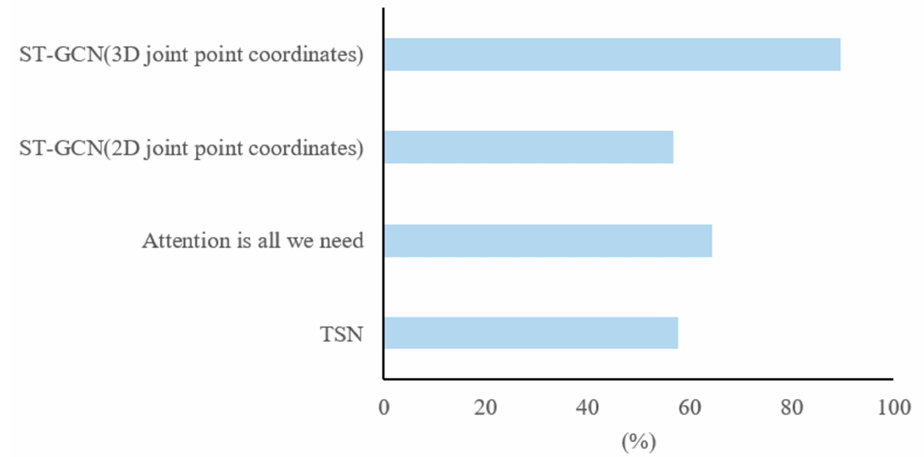
Figure 6. Recognition results of different methods in self-built basketball dataset.